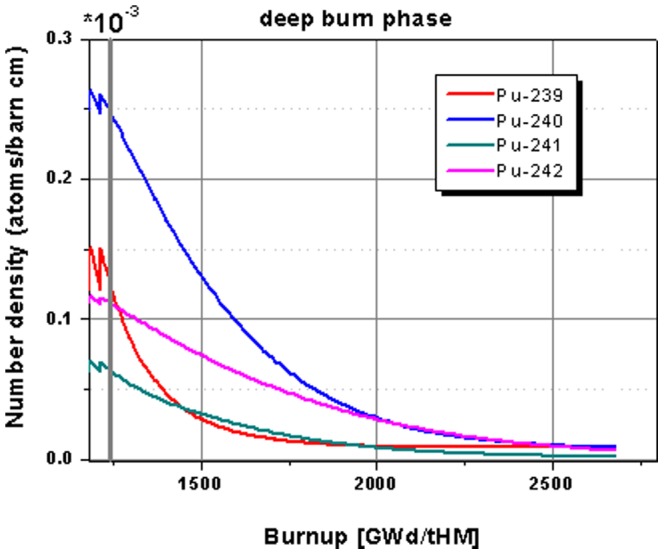
Highlight on the evolution of the plutonium isotope inventory for the continuation in the deep burn phase.